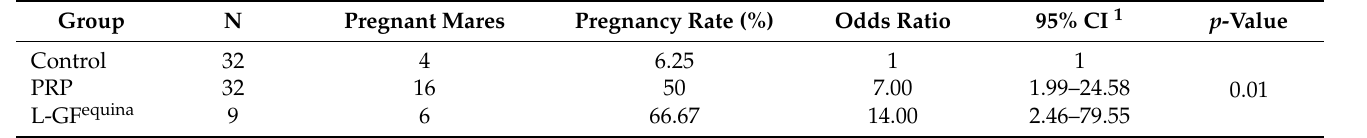
Table 2. Effect of the PRP treatment on the pregnancy rate of Arabian